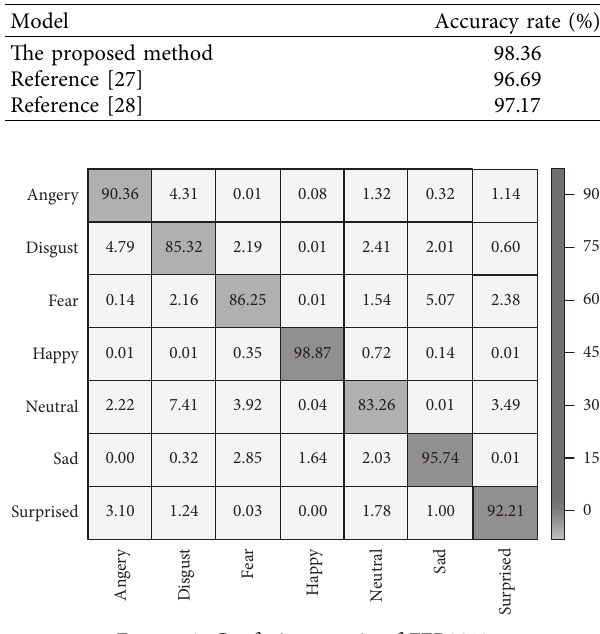
Table 3: Comparison of different algorithms.